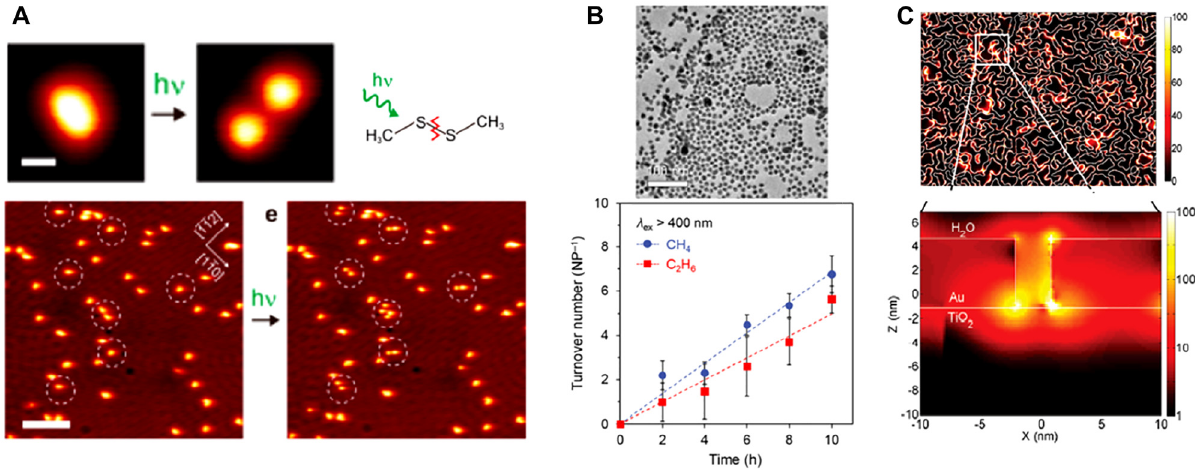
Figure 19: Experimental demonstration of plasmonic induced photoreaction. (A)STMmonitoredphoto-dissociationofsulfidebondsofdimethyldisulfideonAgorCusurfacewith532nmexcitation[237].(B)Photo-inducedCO 2 conversion to CH 4 and C 2 H 6 via plasmonic excitation of Au nanoparticles [236]. (C) Plasmonic enhanced water splitting in Au nanogap structures